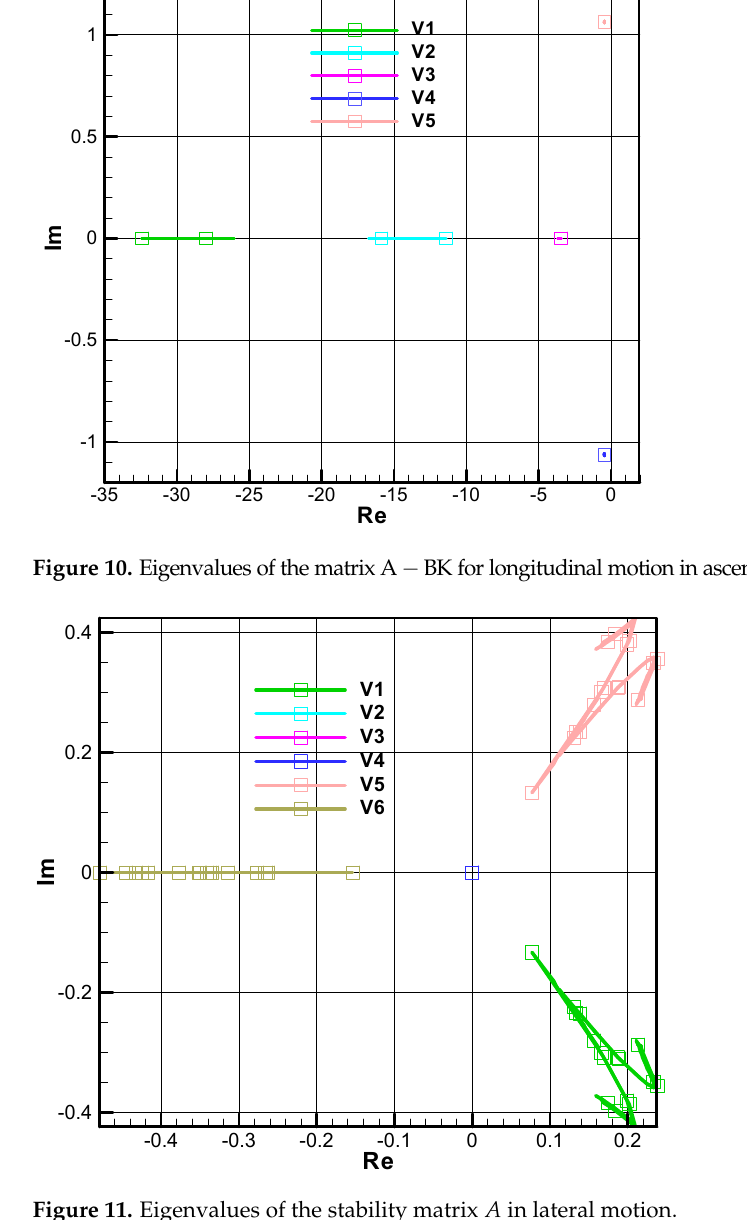
Figure 11. Eigenvalues of the stability matrix A in lateral motion